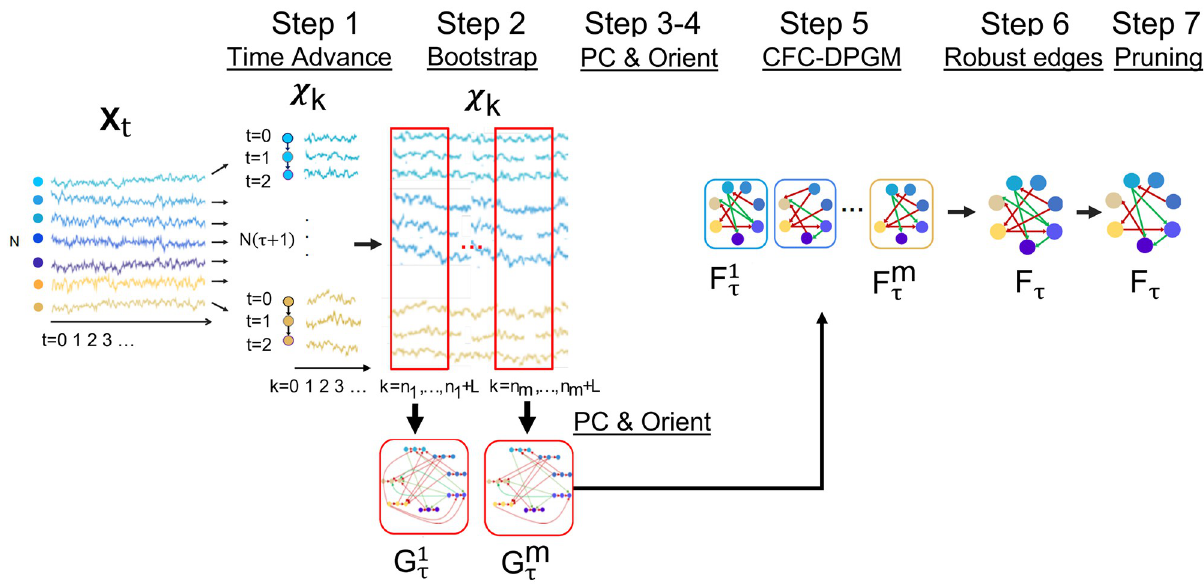
Fig 2. The TPC algorithm. Illustration of Steps 1–7 in the TPC Algorithm: Time Advance, Bootstrap, PC, Orient, Rolled CFC-DPGM, Robust edges and Pruning.